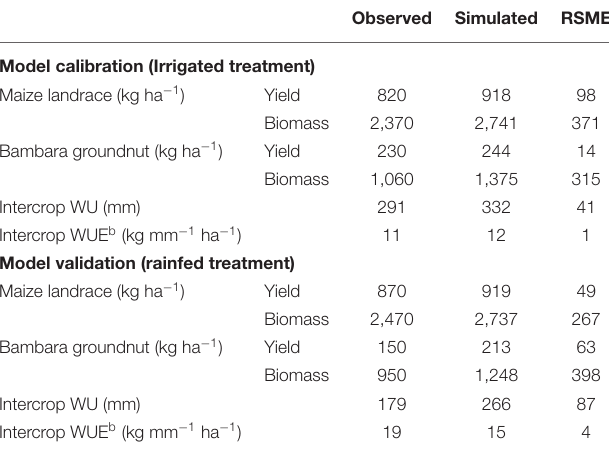
TABLE 4 | Calibration and validation results for observed and simulated outputs for maize landrace and bambara groundnut intercrop system for final biomass (kg ha − 1 ), yield (kg ha − 1 ) and intercrop system water use